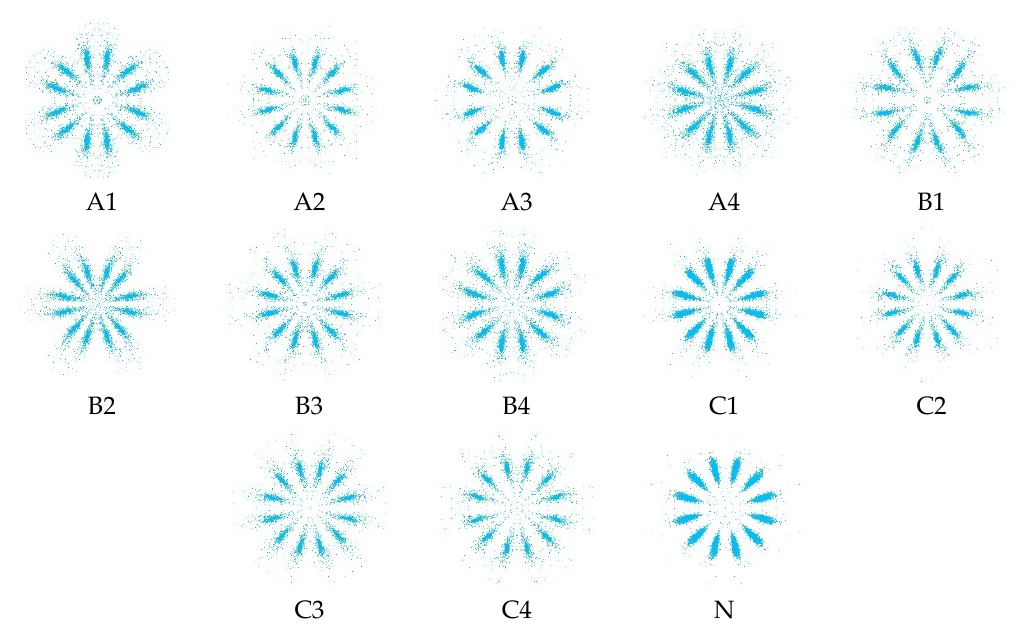
Figure 20. SDP images of 13 bearing states.